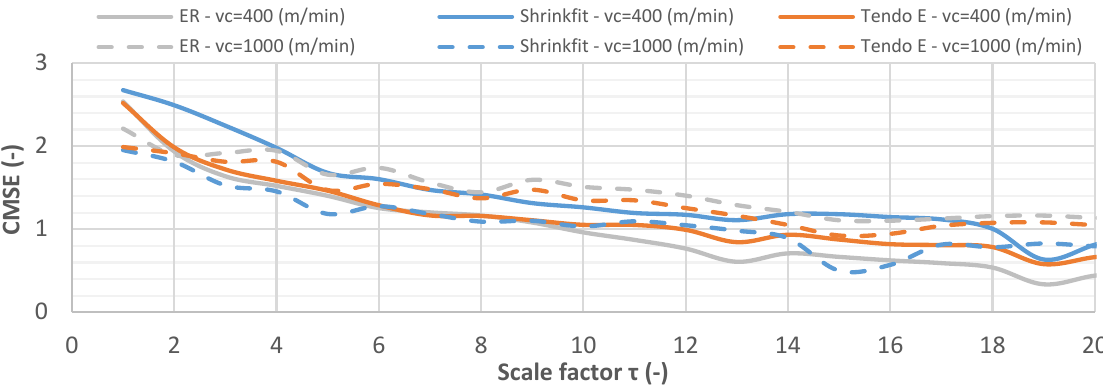
Figure 20. CMSE for vibration acceleration signals while milling at v c = 400 m/min and v c = 1000 m/min (f z = 0.15 mm/tooth, a p = 6 mm).